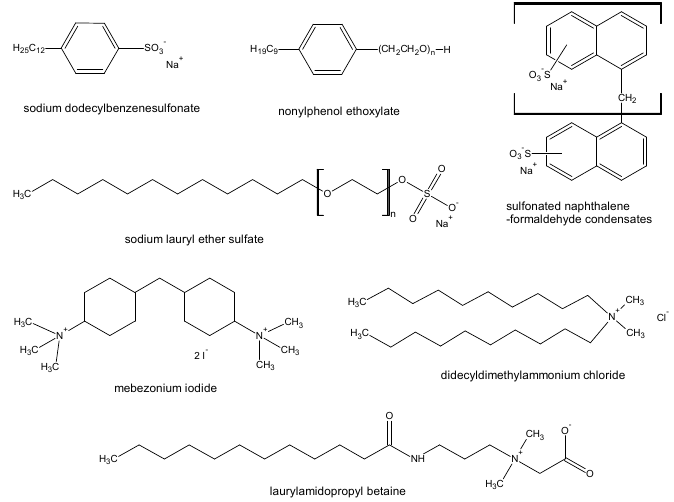
Figure 7. Structures of selected surfactants.